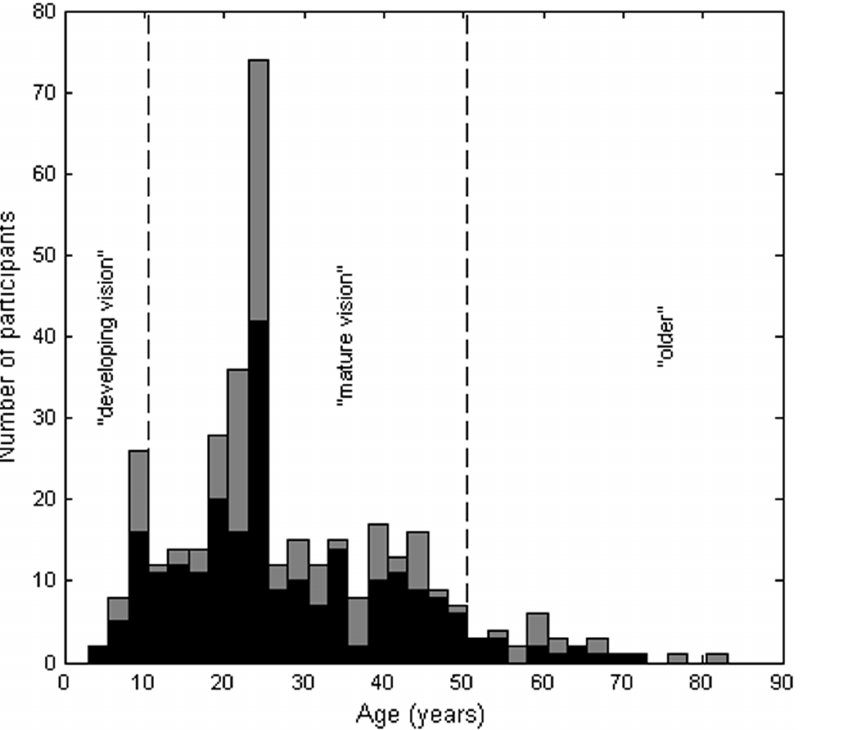
Figure 1. Frequency histogram of participant ages, in bins of width 2.5 years. Vertical dashed lines separate the three age-subgroups examined. Dark bars indicate participants with no visual problems; lighter bars show participants who may have had a visual problem (see Methods for details). Note that in order to preserve anonymity, only year of birth was recorded. For brevity, ‘‘age’’ in this paper means ‘‘year of birth subtracted from year of